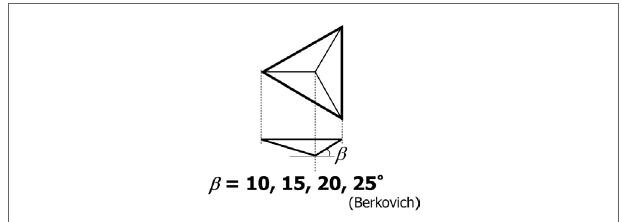
FigUre 1 | schematic illustration of trigonal pyramid indenter . β is the face angle of the indenter and varied from 10° to 25°. FigUre 2 | Photos of the indentation contact regions of soda-lime glass under (a) 10° and (B) 25° indenters . The indentation load is 1.0 N.